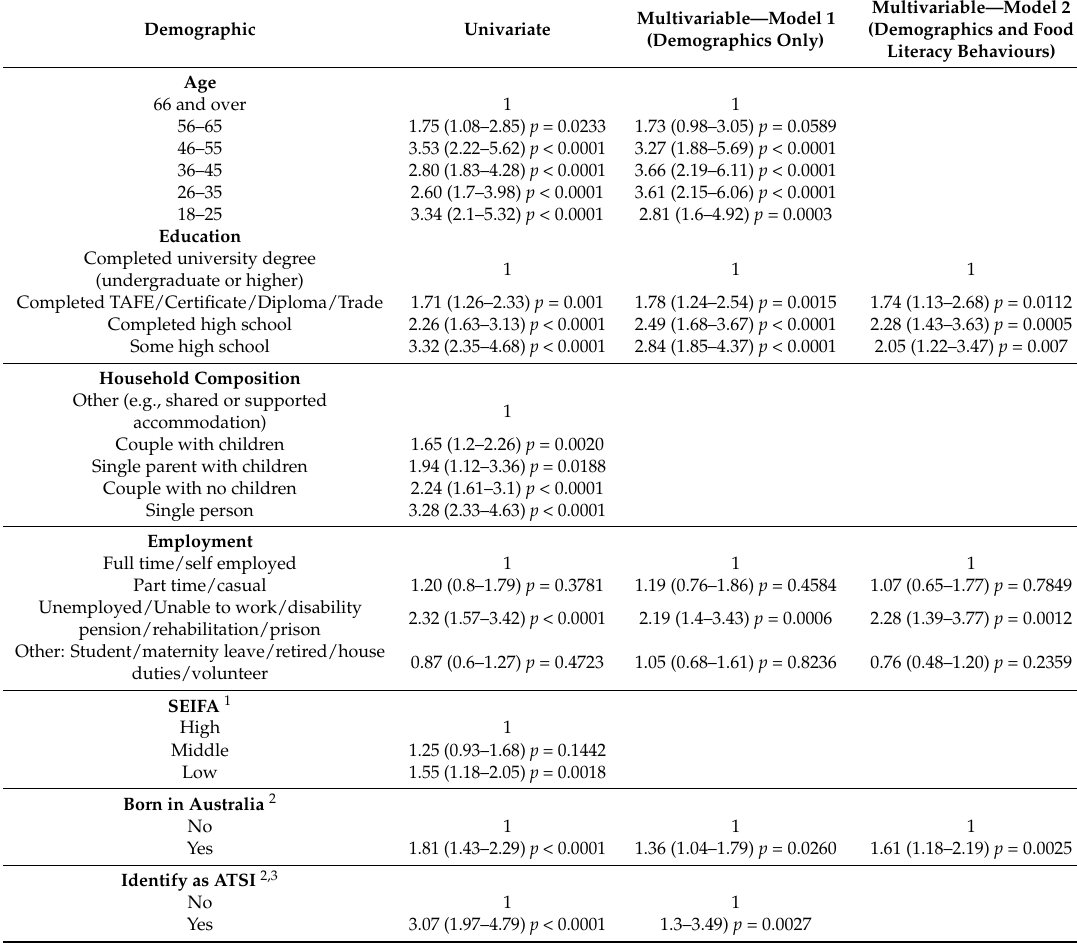
Table 5. Demographic variables and its association with food